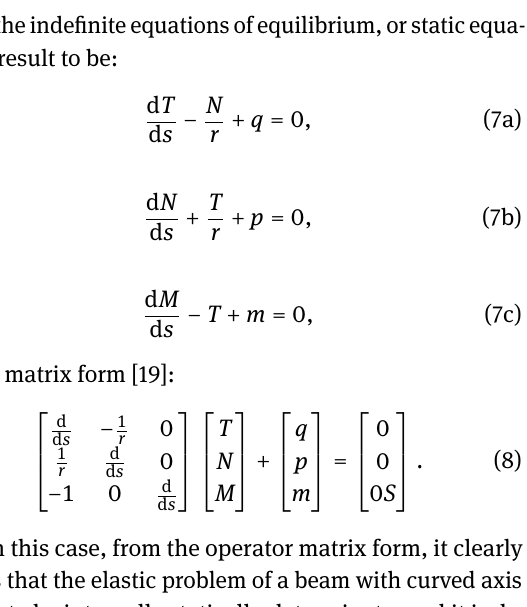
On the other hand, the radial displacement v produces an additional axial dilation ε ( v ) which is given by (Fig- ure